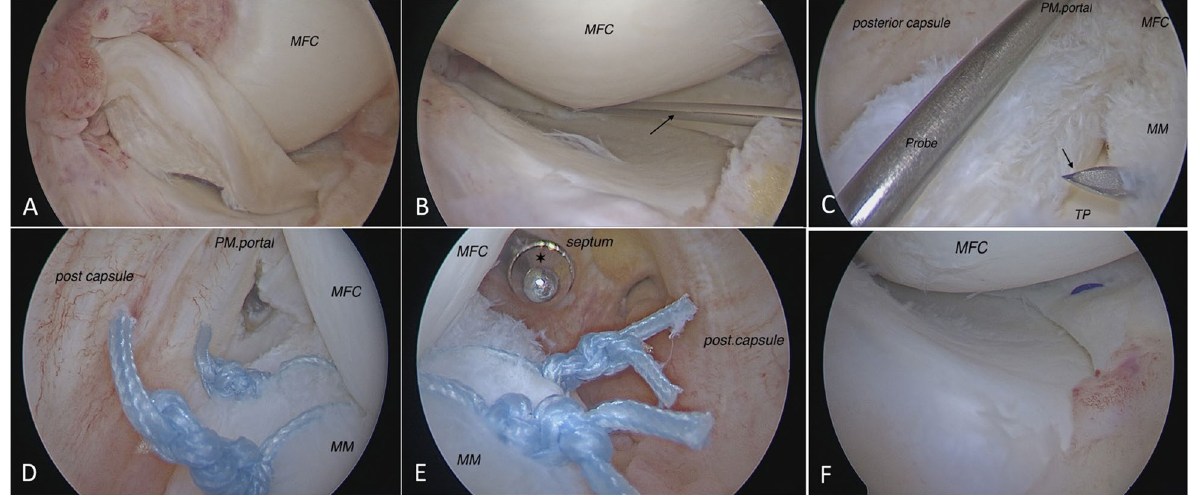
Fig. 1 A Locked unstable medial meniscus in an anterolateral portal view of a right knee. Anterolateral portal ( B ) and posterolateral trans-septal ( C ) views show the torn medial meniscus fixed using a needle ( arrow ) percutaneously. Posterolateral trans-septal ( D ), posteromedial ( E ), and anterolateral portal ( F ) views after meniscal repair. MM medial meniscus, TP tibial plateau, MFC medial femoral condyle, * arthroscopic sheath, PM. portal posteromedial